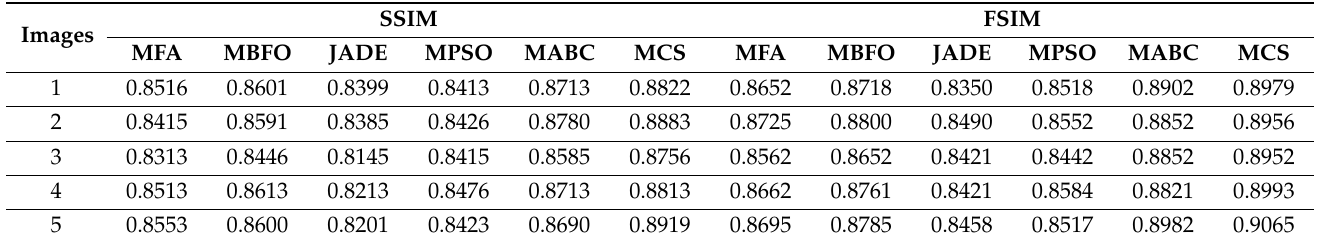
Table 6. SSIM and FSIM using different optimization algorithms with minimum cross entropy.